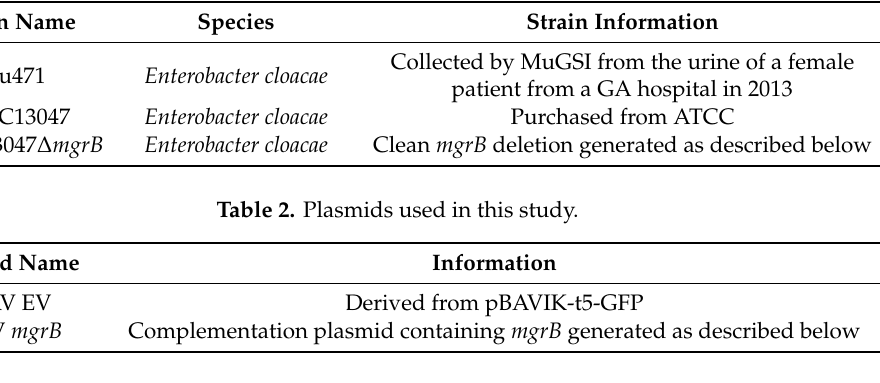
Table 3. Primers used in this